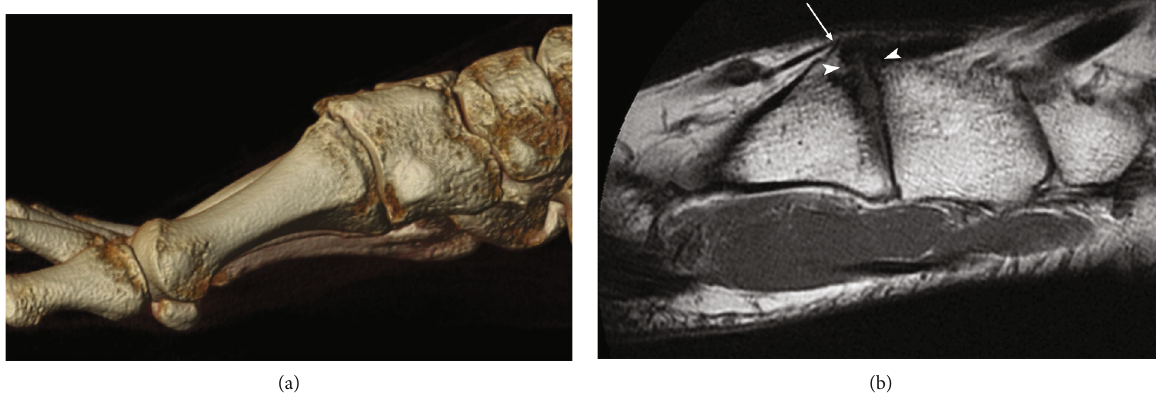
Figure 4: (a) Volume rendered CT image of the medial aspect of the right foot shows the same degenerative disorders as those shown in x-ray images, with a spiky osteophytic deformation on the dorsal aspect of the fi rst tarsometatarsal joint. (b) Sagittal T1-weighted MRI image of the right foot shows a dorsal joint space narrowing (arrowheads), hypo T1 subchondral sclerosis and osteophyte formation